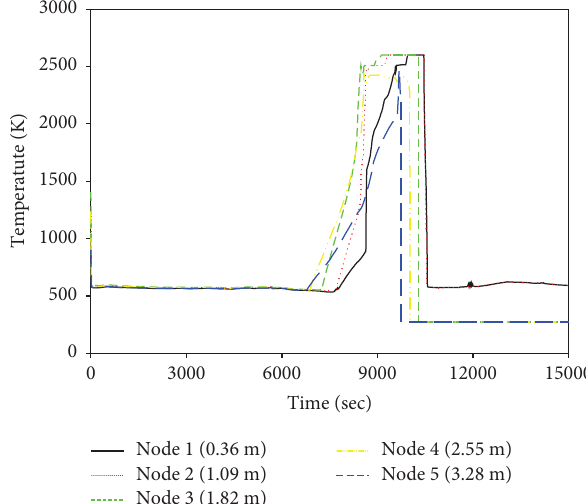
Figure 10: CINEMA results on fuel temperature in TMI-2 severe accident.